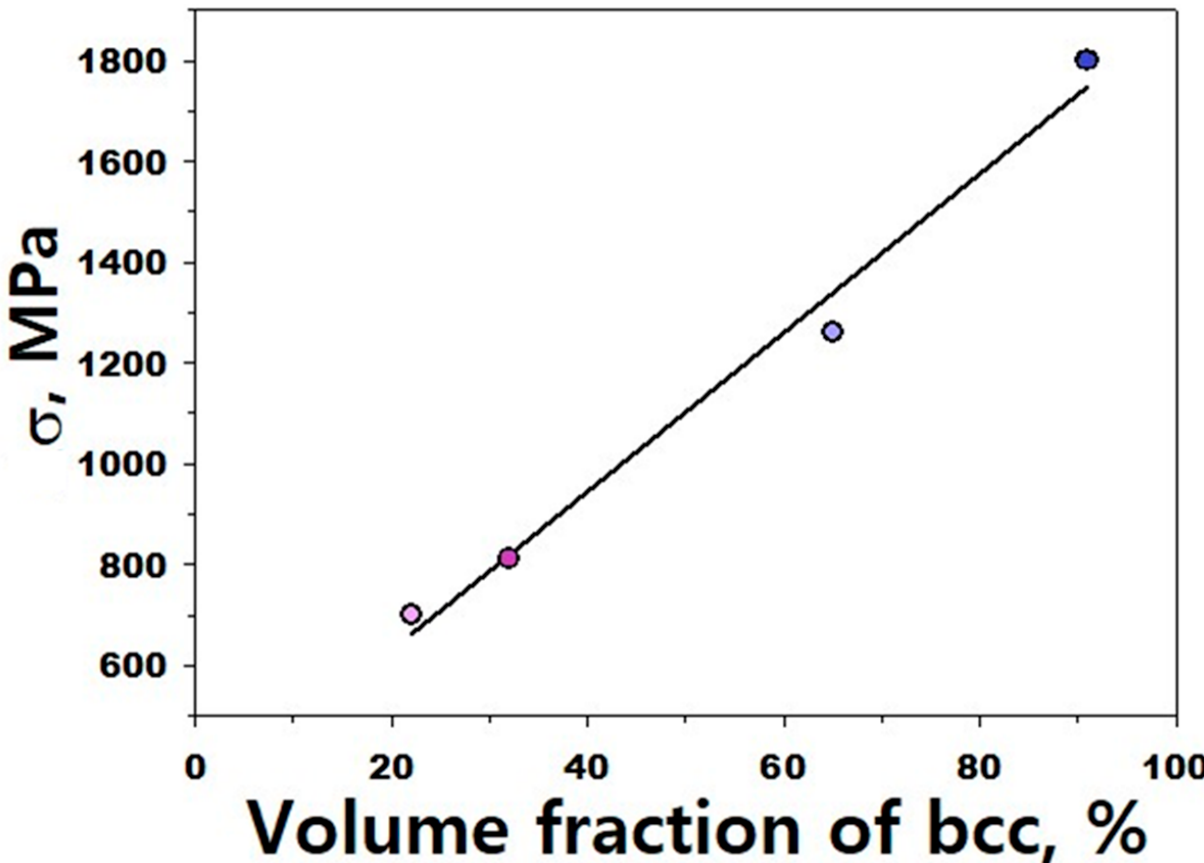
Figure 12. Strength of the Fe